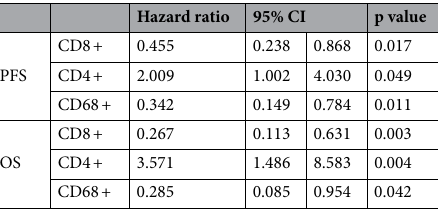
Table 3. Multivariable analysis association between progression-free survival (PFS)/overall survival (OS) and IHC staining status of CD8, CD4, and CD68.